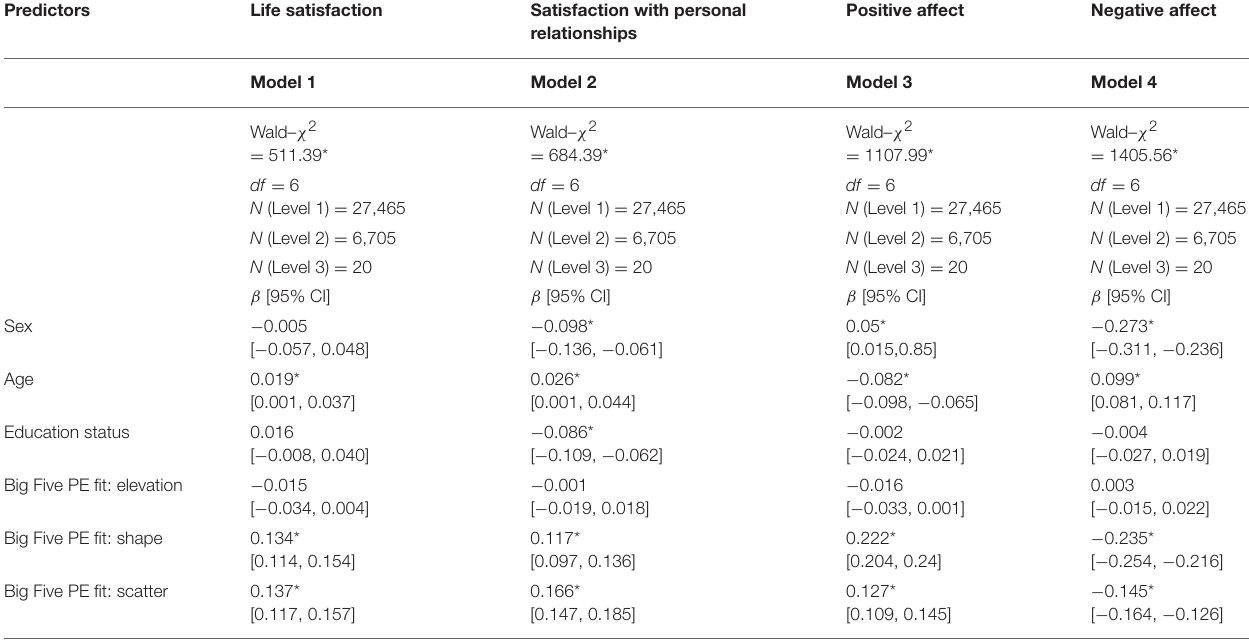
TABLE 4 | MLM, Listing Predictors and Dependent Variables